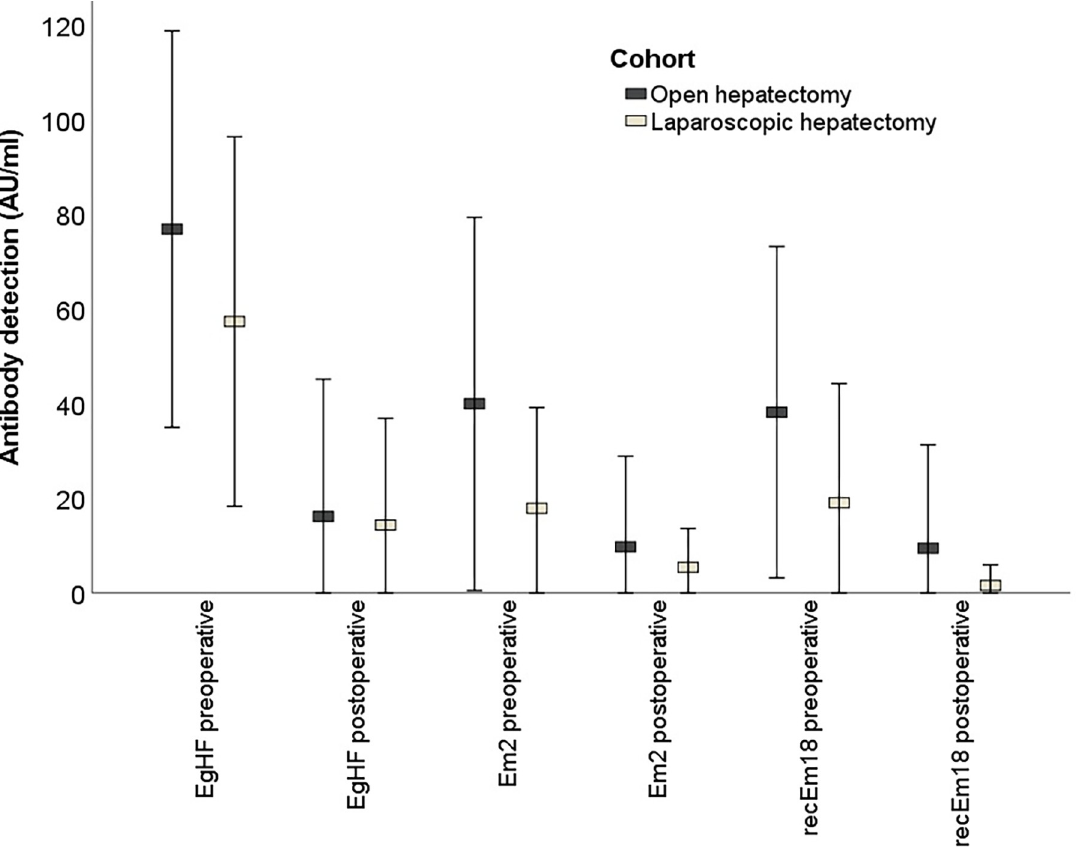
Fig 3. Boxplots for the pre- and postoperative serology of EgHF, Em2 and recEm18 (AU/ml). The bars show mean values and T-bars standard deviations respectively. A significantly lower postoperative antibody level is seen in all sampled antibodies. AU/ml, arbitrary units per milliliter; EgHF, Echinococcus granulosus hydatid fluid; Em2, Echinococcus multilocularis 2; recEm18, recombinant Echinococcus multilocularis